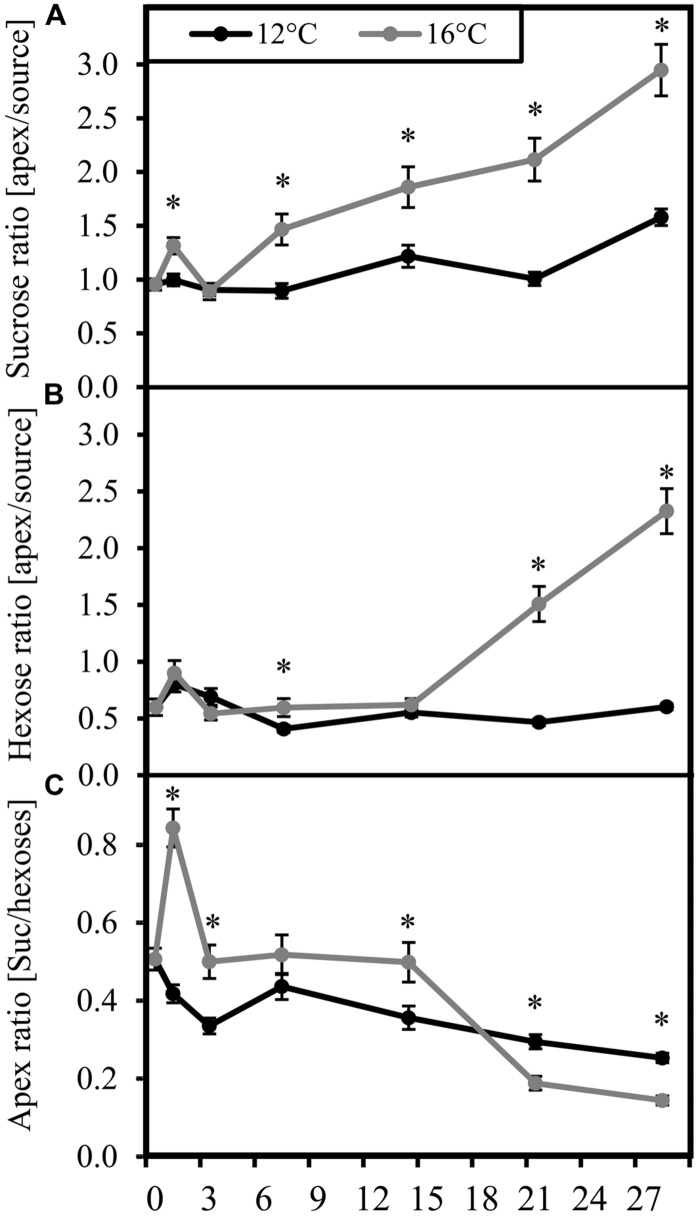
Carbohydrate ratios. Ratios (black: 12°C, gray: 16°C) of carbohydrate concentrations. (A) apex/source ratio of sucrose; (B) apex/source ratio of hexoses; (C) sucrose/hexose ratio in the apex. (DoT = days after differentiation of temperature; n = 12; data are means ± SE, asterisks indicate significant differences between temperature treatments for a given sampling time, P ≤ 0.05).